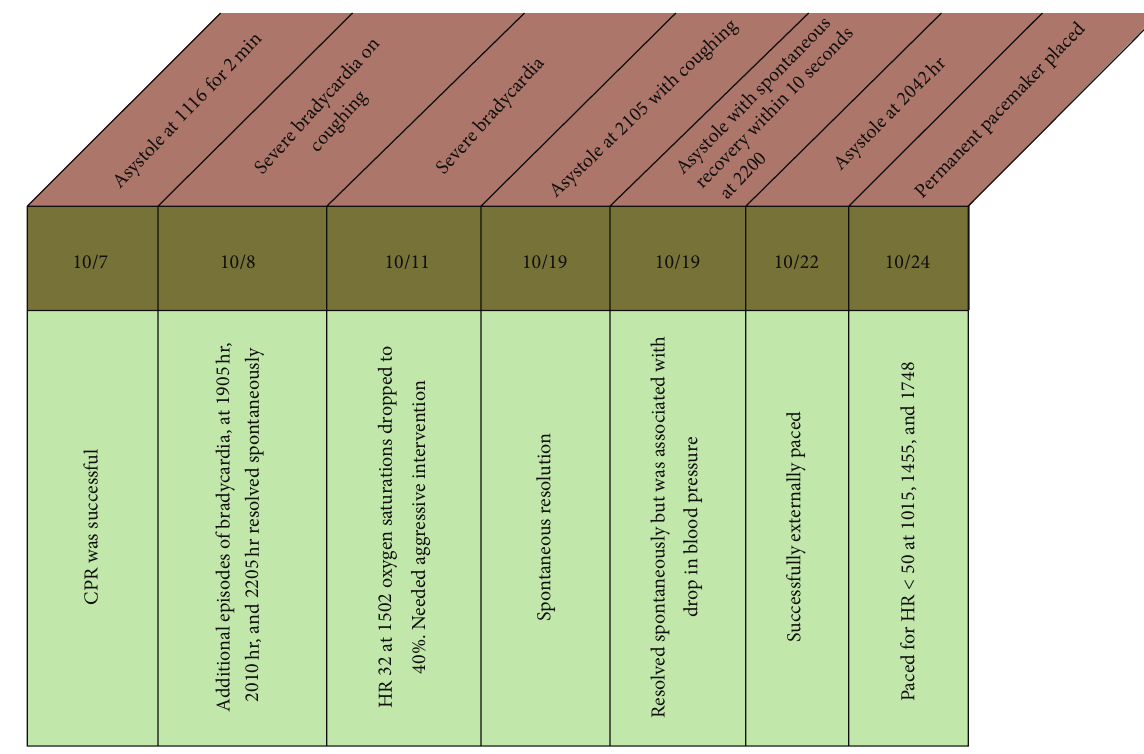
Figure 3: Timeline of autonomic instability and interventions in the